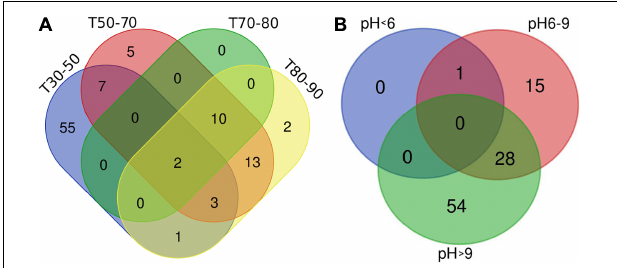
FIGURE 2 | OTU Venn diagram illustrating distribution of cyanobacterial OTUs among the four groups of temperature range (A) and three groups of pH range (B) . T indicates the temperatures of the water samples or the hot spring water temperatures of other sample types. T30–50 (Group 1: 30–50 ◦ C), T50–70 (Group 2: 50–70 ◦ C), T70–80 (Group 3: 70–80 ◦ C), and T80–90 (Group 4: 80–90 ◦ C). The Venn diagram was generated using the OmicStudio tools